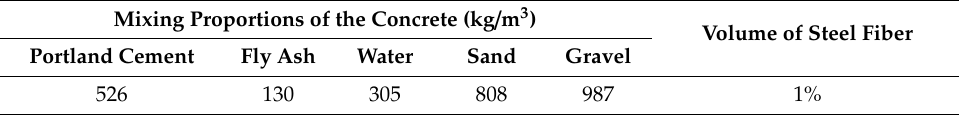
Table 3. Mixing proportions of the